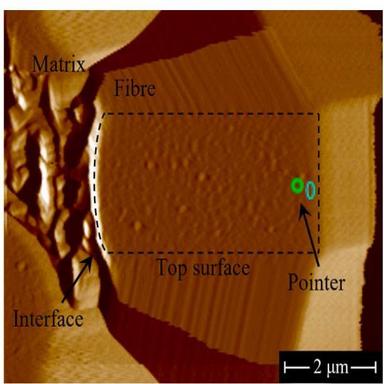
Scanning probe microscopy (SPM) topographic image of the specimen surface, with the microscope pointer highlighted.